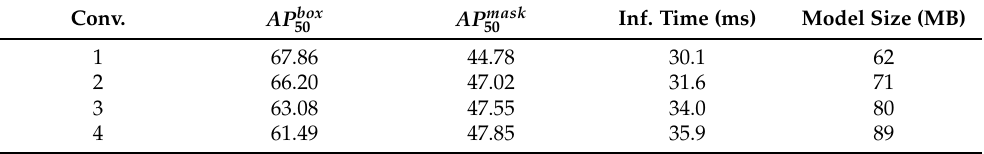
Table 4. Design of convolution number in bounding box regression and classification branches.